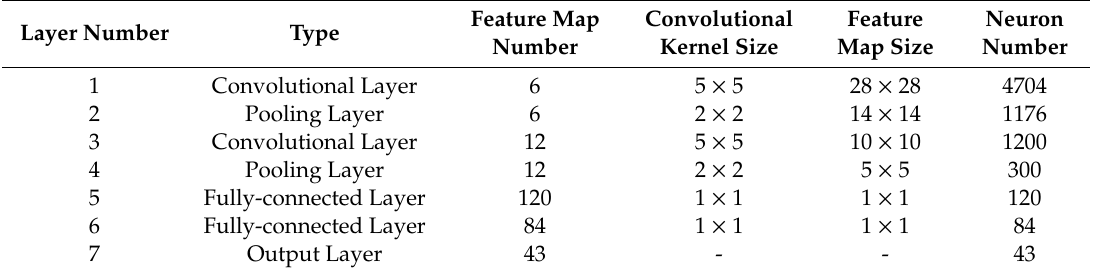
Table 2. The parameter settings of the improved LeNet-5 network